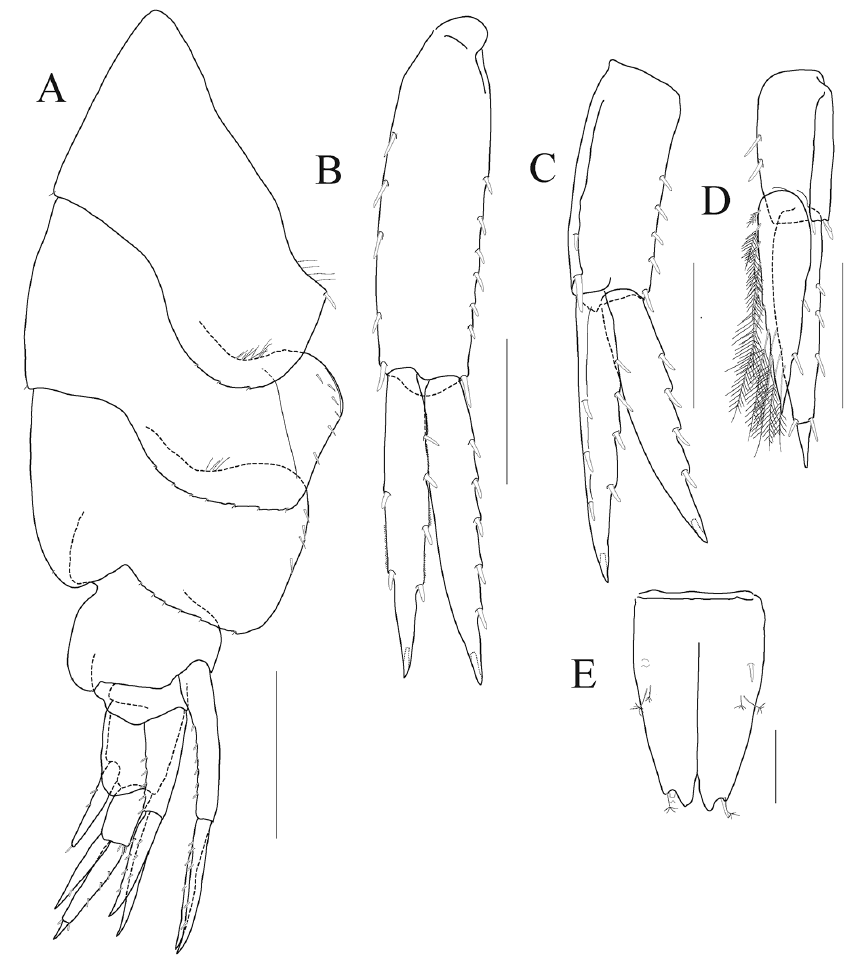
Figure 4. Aroui minusetosus sp. n., holotype male, NIBRIV0000806536, 4.3 mm. A pleon, lateral B uropod 1 C uropod 2 D uropod 3 E telson. Scale bars 0.1 mm ( E ), 0.2 mm ( B–D ), 0.5 mm ( A